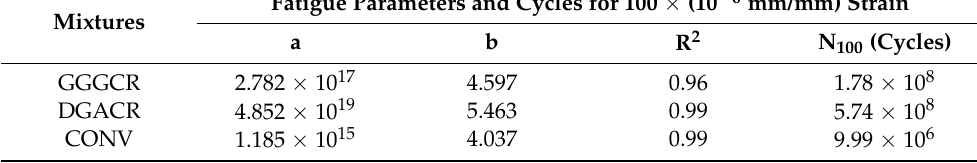
Table 3. Asphalt mixtures fatigue parameters and N 100 .